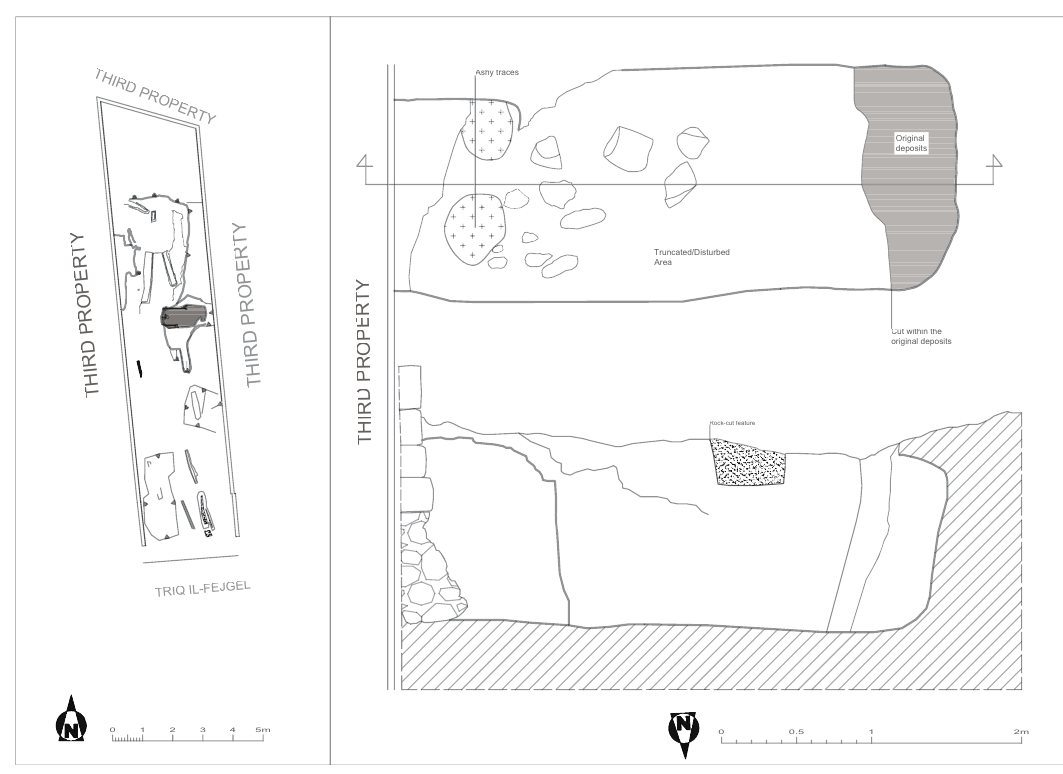
Figure 2: General layout of the plot ( courtesty of QPML ) , plan and section/elevation of the tomb in Triq Fej ġ